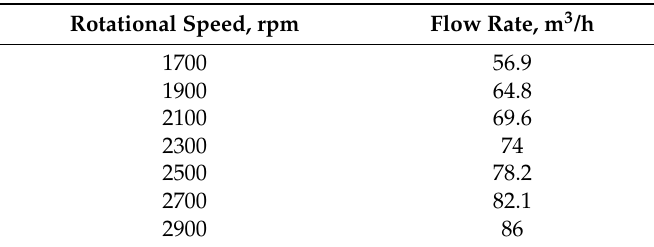
Table 3. Rotational speeds and corresponding flow